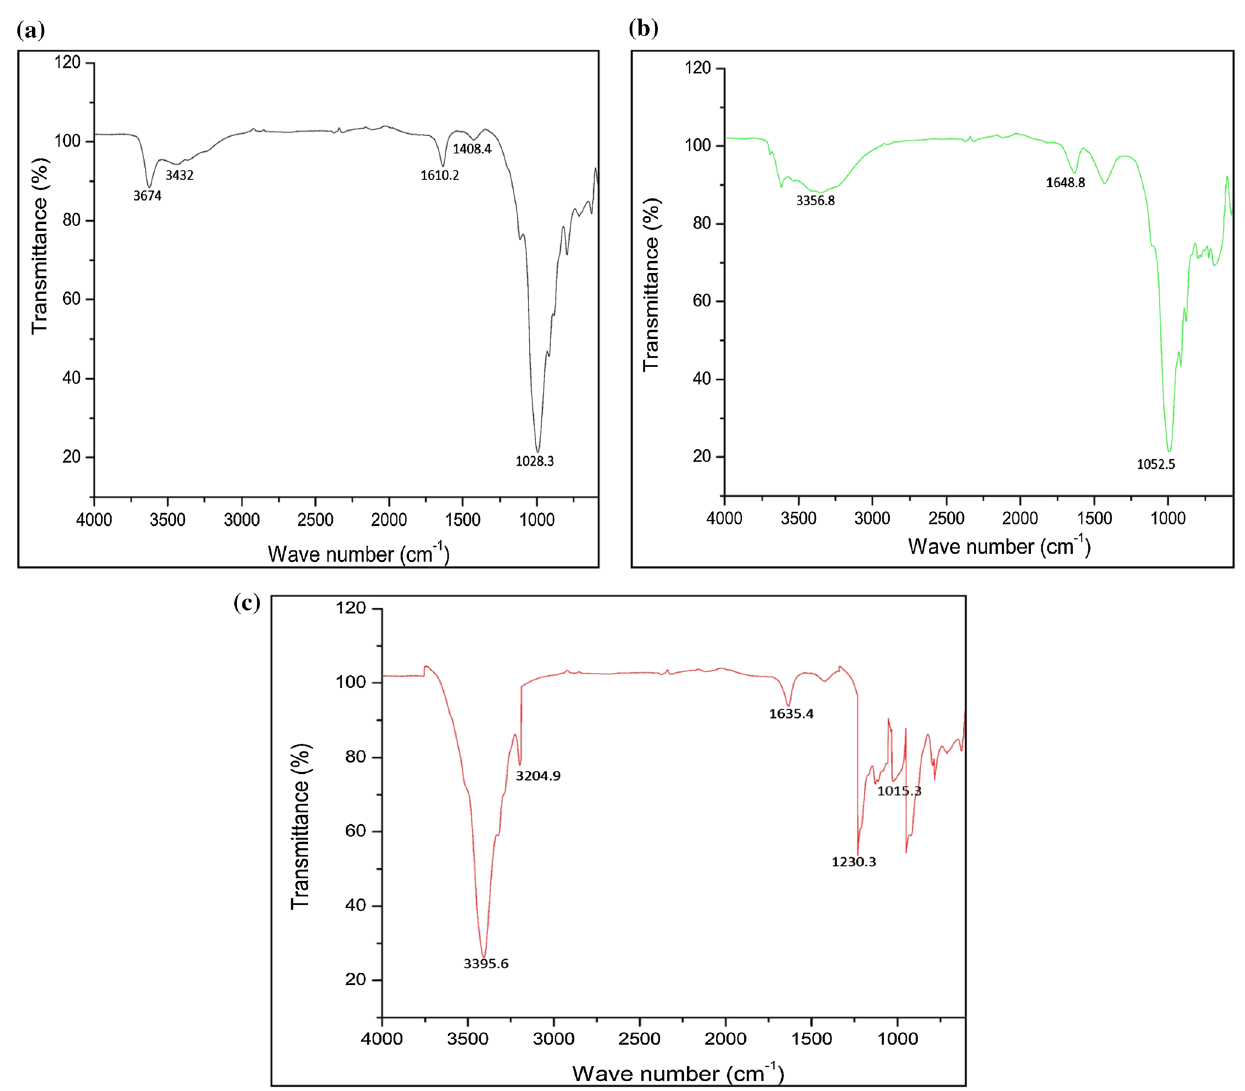
Fig. 2 FT-IR spectra of a AWS (Without activation), b KOHAWS1 and c